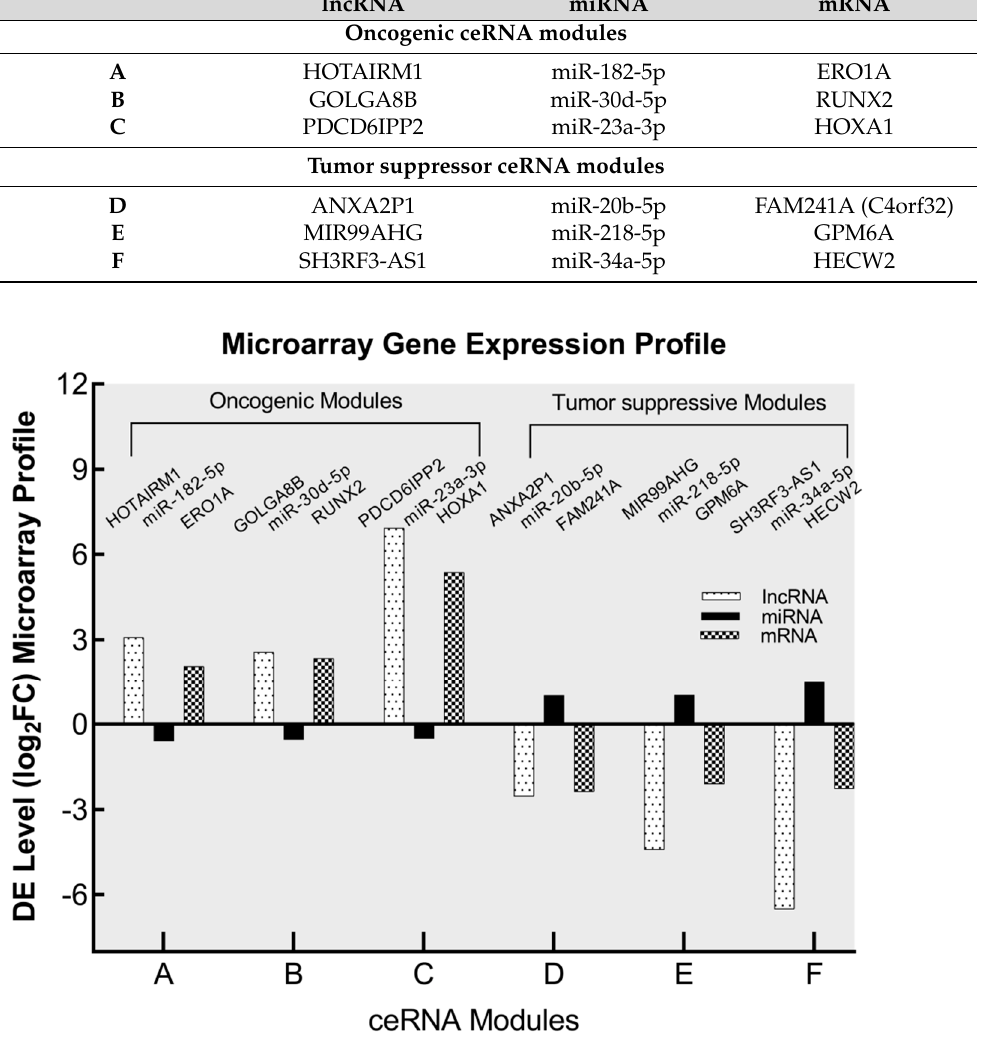
Figure 5. The potential oncogenic and tumor suppressor RNAs in BEAS-2B-Cr(VI) cells. The fold changes (compared to control cells) of expression levels of each RNA component are calculated using values from each type of RNA microarray expression profile.